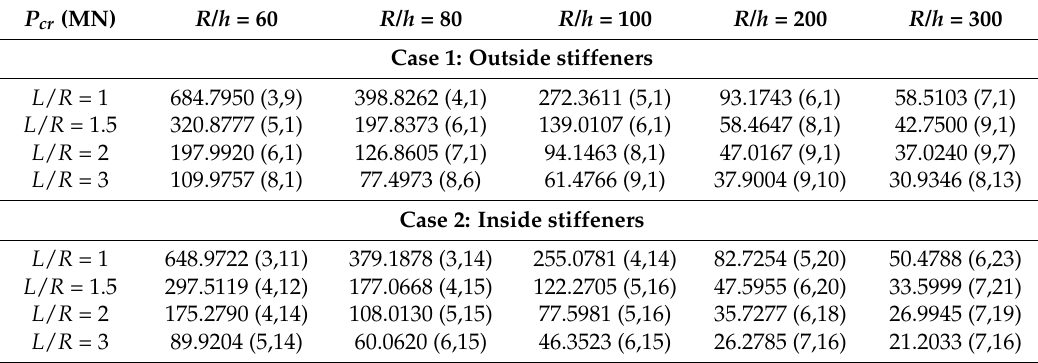
Table 7. Critical compression load P cr for various values of L / R and R / h